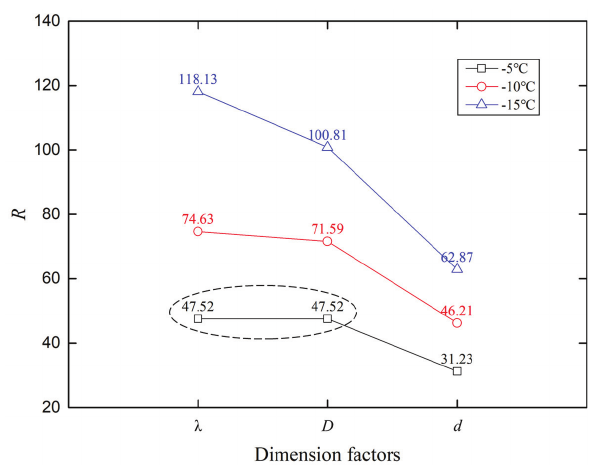
Figure 16. Calculation results of range analysis. Table 8. The results of variance analysis and F-test.